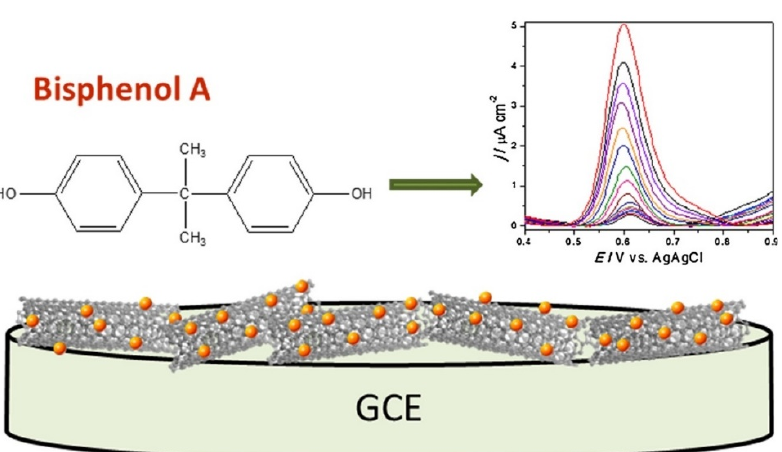
Figure 4. Depiction of Au nanoparticles decorated onto MWCNT oxidized to generate surface carboxylate groups and drop-cast onto GCE. Differential pulse voltammetry (DPV) was applied to detect bisphenol A. Reproduced from reference [100] with permission from Elsevier, copyright 2017.